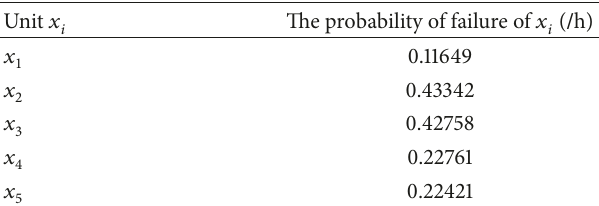
Table 9: Conditional probability table of root nodes. Unit 𝑥 𝑖